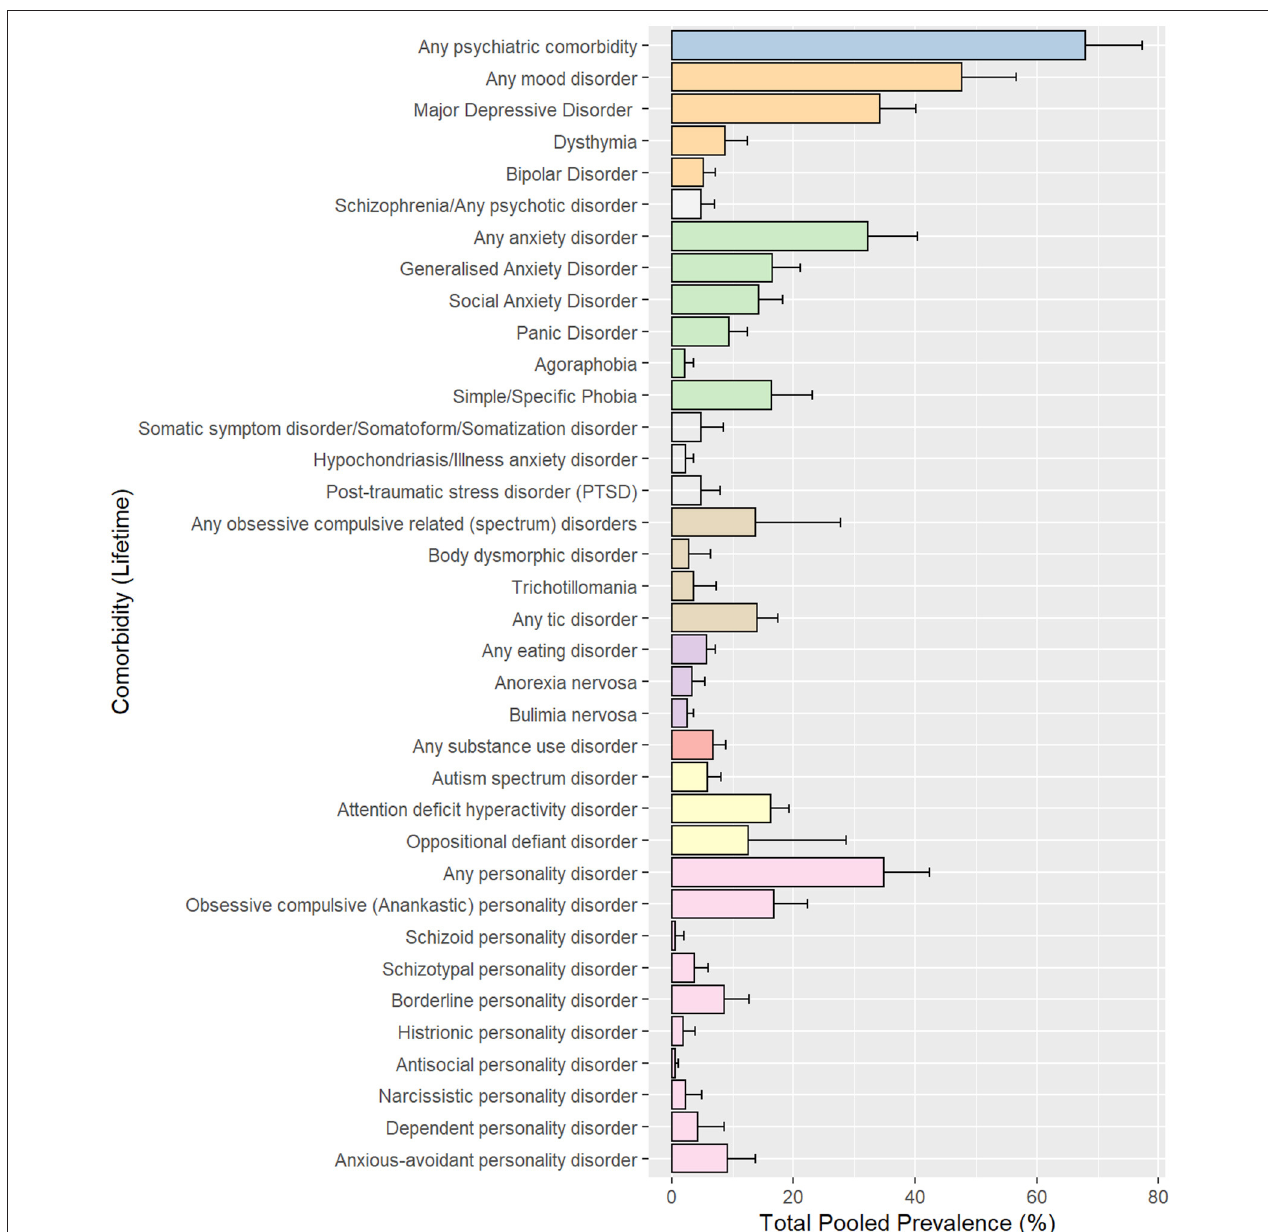
FIGURE 2 | Pooled prevalence rates by